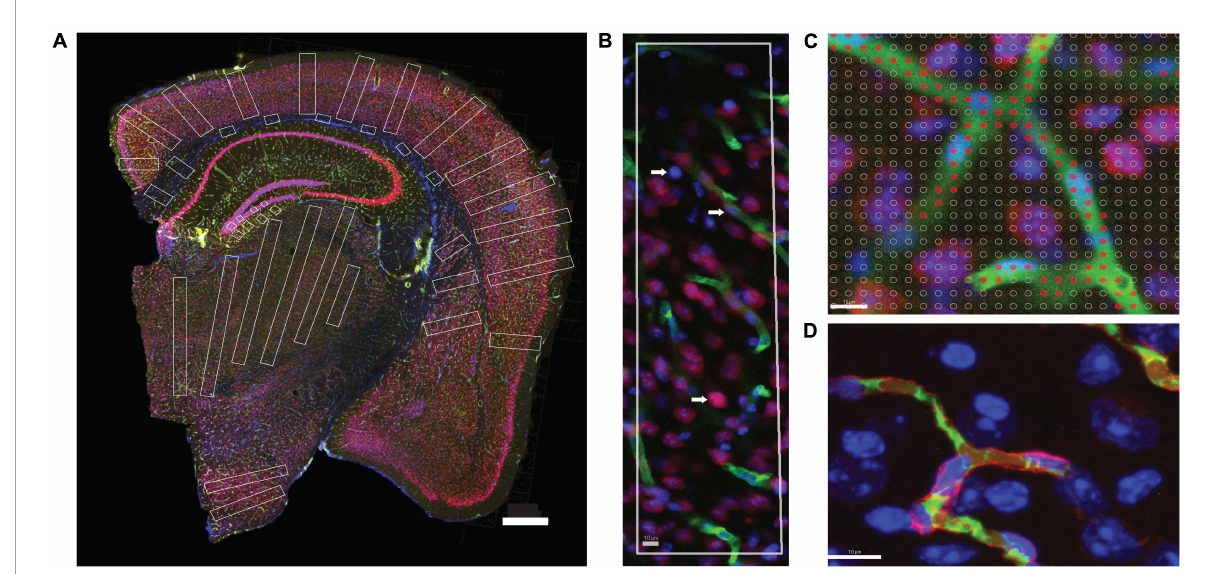
FIGURE2 Two-dimensional image analysis. (A) Areas sampled for 2D quantification are shown in white across structures in a coronal section of the mouse brain. Scale bar, 500 µ m. (B) ROI throughout the cortical gray matter, from pial surface to white matter interface, showing microvasculature labeled with anti-collagen IV (green), neurons labeled with anti-NeuN (red) and DAPI to reveal all cell nuclei (blue). Cell nuclei appearing inside green-labeled blood vessels are considered capillary-associated nuclei (and therefore, “endothelial cells”); cell nuclei double-labeled in red are considered neuronal cell nuclei; all remaining nuclei are identified by exclusion as glial cell nuclei. (C) A Cavalieri estimator grid of 4 µ m spacing (shown) was applied to images acquired under 20 × magnification, and a 2 µ m grid was applied to images acquired under 63 × magnification. The points marked in red correspond to the area of the image occupied by capillaries. Scale bar, 10 µ m (D) . Superposition of FITC-dextran (green, lumen) and collagen IV (red, basal lamina) labeling of capillaries. Single image acquired under 63 × magnification. Scale bar, 10 µ